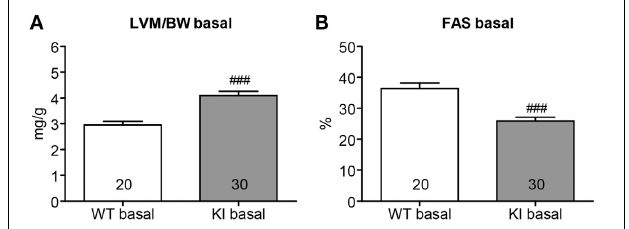
FIGURE 1 | Echocardiographic analysis in KI vs. WT mice under basal conditions. Echocardiographic analyses were performed in KI (gray) and WT (white) mice under basal conditions, i.e., before minipump implantation. (A) Left ventricular mass-to-body-weight ratio (LVM/BW). (B ) Fractional area shortening (FAS). Data are expressed as mean ± s.e.m. with ### P < 0 . 001 vs. WT, unpaired Student’s t -test. The number of animals is indicated in the